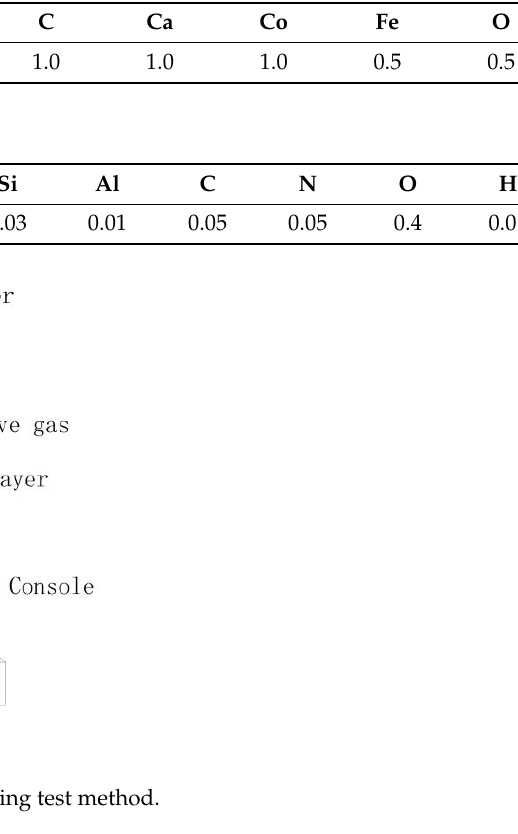
Table 2. Chemical composites of TiB 2 (wt.%).